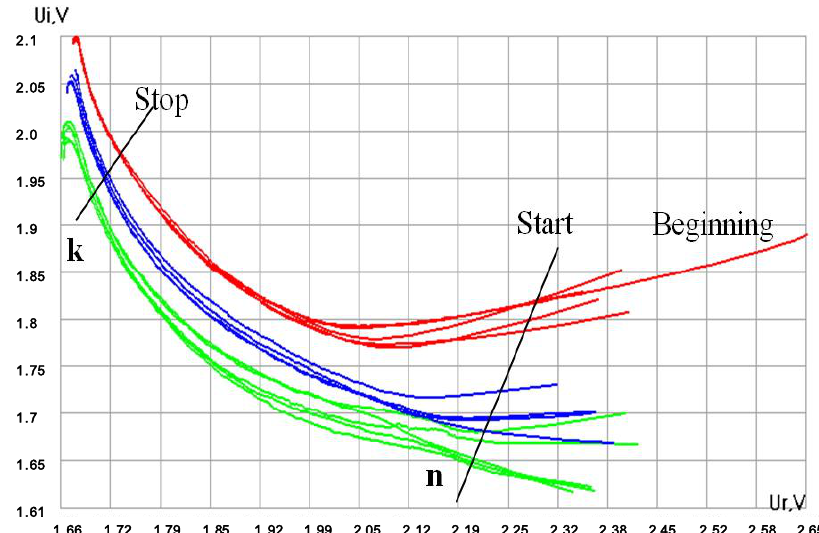
Figure 5. An example of calculating the di ff erence index (DI) of two hodographs as the average distance between the points of the corresponding samples: n is the starting point of reference; k is the end point of reference.